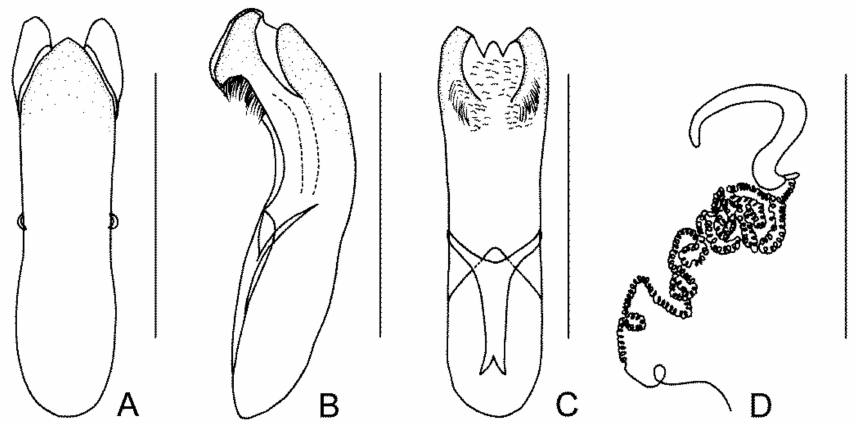
Figure 9. Cryptocephalus ( Burlinius ) glabrelegantulus Duan & Zhou, sp. nov.: ( A ) dorsal view of aedeagus; ( B ) lateral view of aedeagus; ( C ) ventral view of aedeagus; ( D ) spermatheca. (Scale bars: 0.5